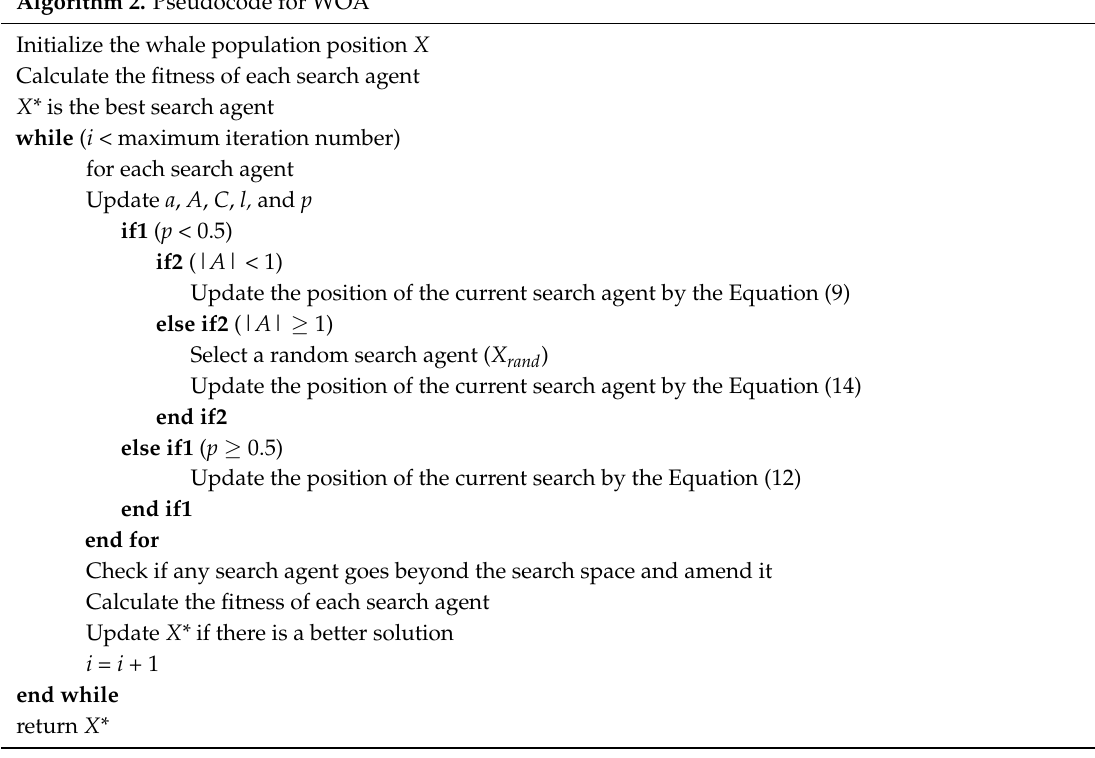
Algorithm 2. Pseudocode for